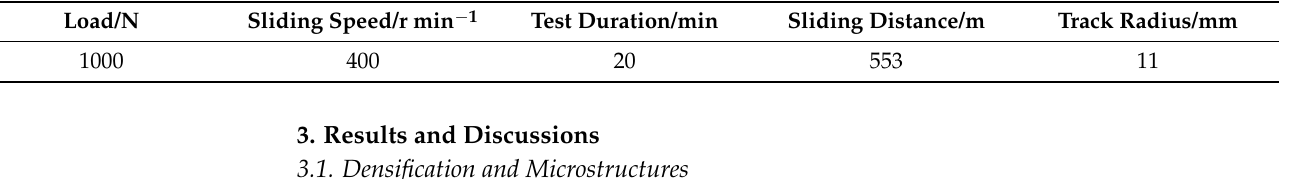
Table 5. The experimental parameters of the pin-on-disk wear